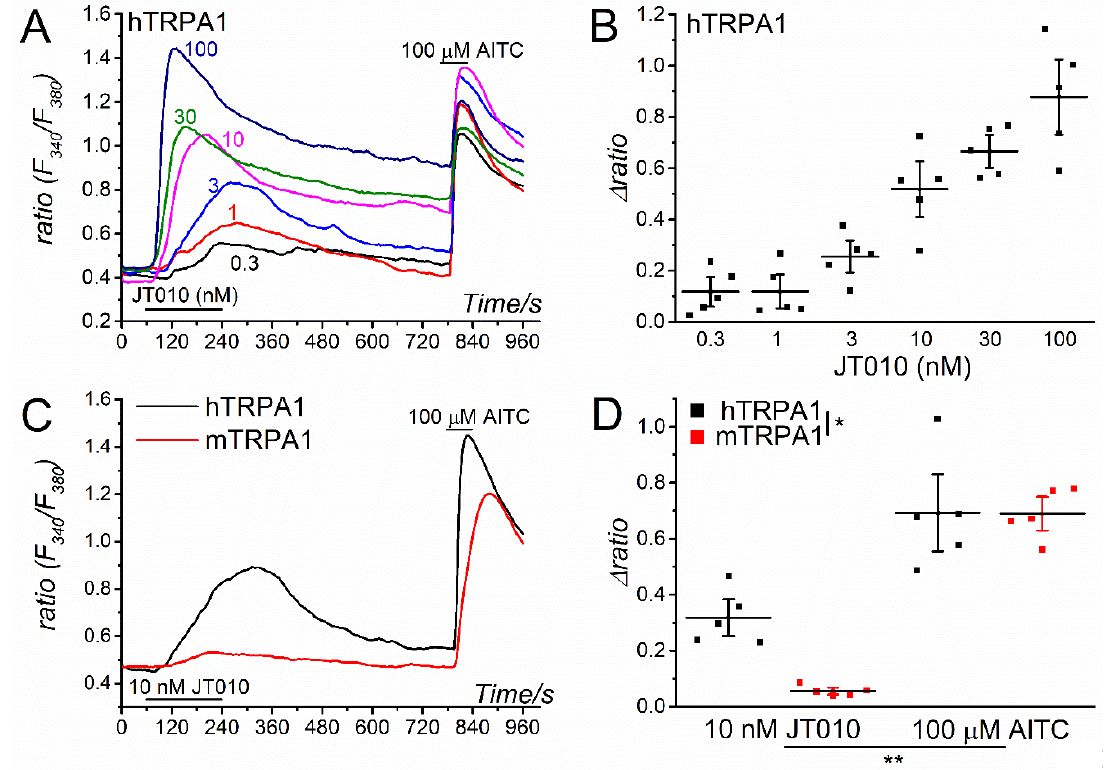
Figure 1. The hTRPA1-specific activation by JT010. ( A , B ) JT010 at a concentration range from 0.3 to 100 nM induced Ca 2+ responses in representative HEK-hTRPA1 cells ( A ) and the peak JT010-induced Ca 2+ response ( ∆ ratio) in HEK-hTRPA1 cells (five independent experiments) is summarized as a concentration-response relationship ( B ). At the end of each experiment, 100 µ M AITC was applied to confirm hTRPA1 expression. ( C , D ) JT010 and AITC at 10 nM and 100 µ M, respectively, were applied to HEK-hTRPA1 and HEK-mTRPA1 cells, and the measured Ca 2+ response ( C ) and the peak JT010- and AITC-induced Ca 2+ response (five independent experiments each) ( D ) are summarized. Two-way analysis of variance (ANOVA): * p = 0.0279, F = 5.85 (species); ** p < 0.0001, F = 84.5 (drugs); * p = 0.0312, F = 5.58 (interaction). Vertical bars = SEM.